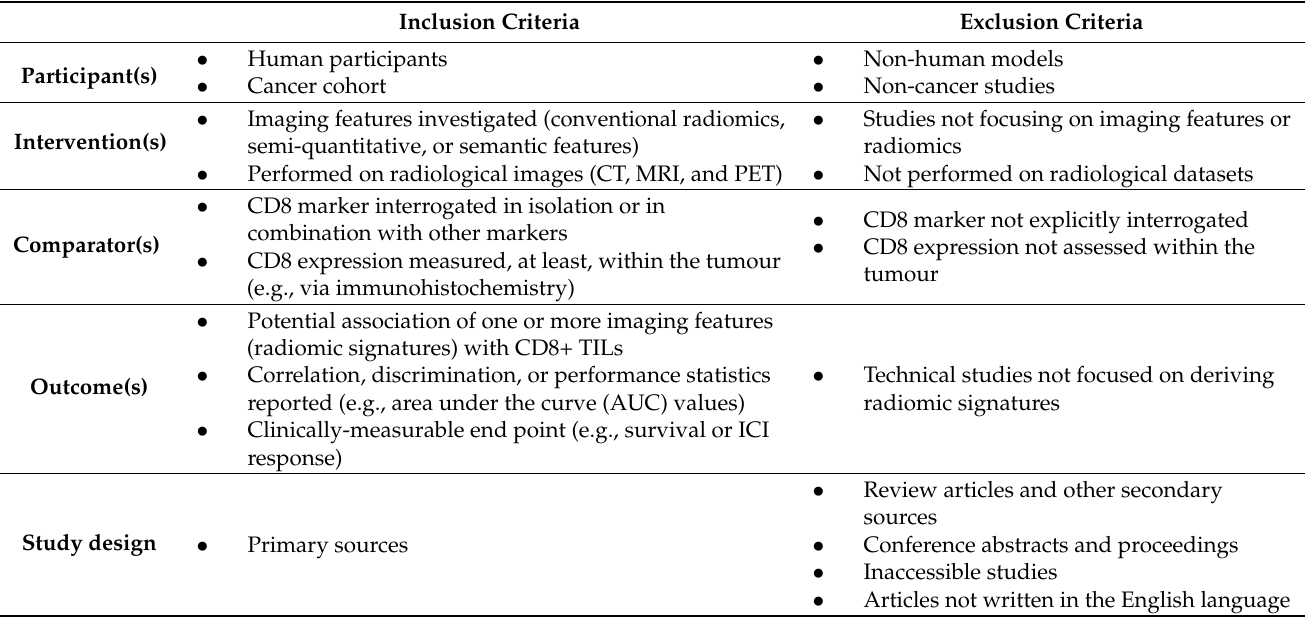
Table 1. Study eligibility